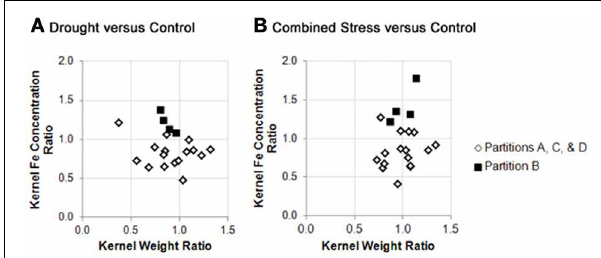
FIGURE 5 | Stability of kernel weight and iron concentration under stress conditions across genotype partition groups. Fold change in kernel weight (X variable) or kernel iron concentration (Y variable) between environmental treatments are plotted as trait ratios (stress: control) for all genotypes in this study. Ratios are shown for: (A) drought vs. control, and; (B) combined stress vs. control. Genotypes from partitions A , C , and D are represented by open markers, and genotypes from partition B are represented by closed markers. Due to missing kernel weight data, trait ratios are not presented for all genotypes. (Genotypes with missing data points can be found in Supplementary File